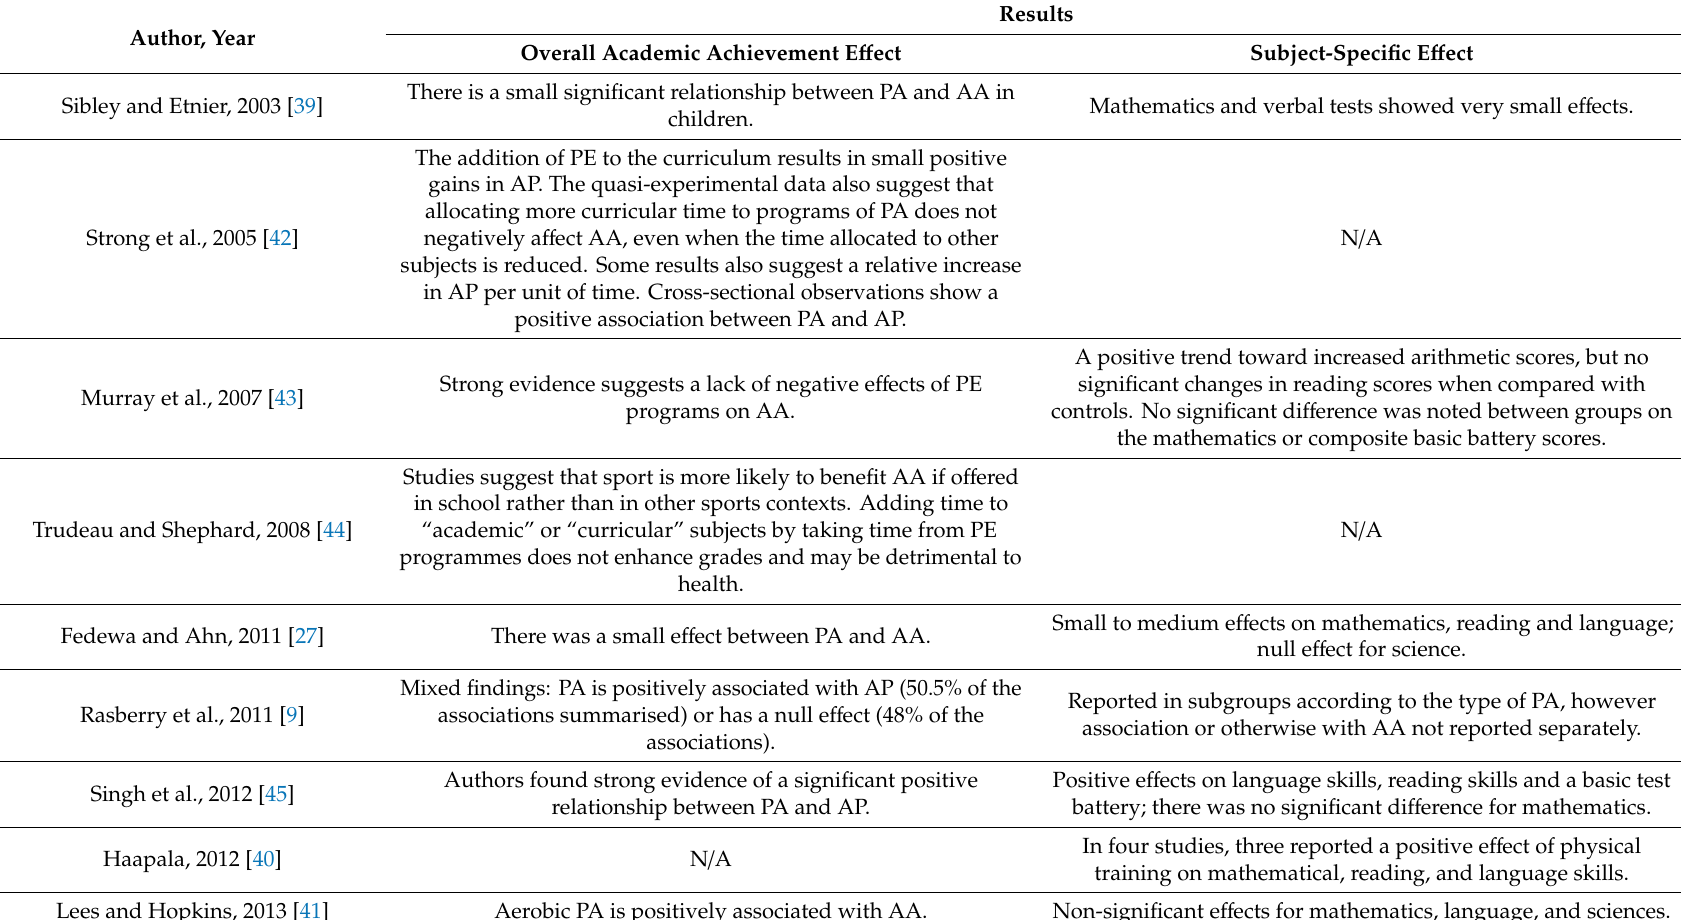
Table 2. Summary of the results included systematic